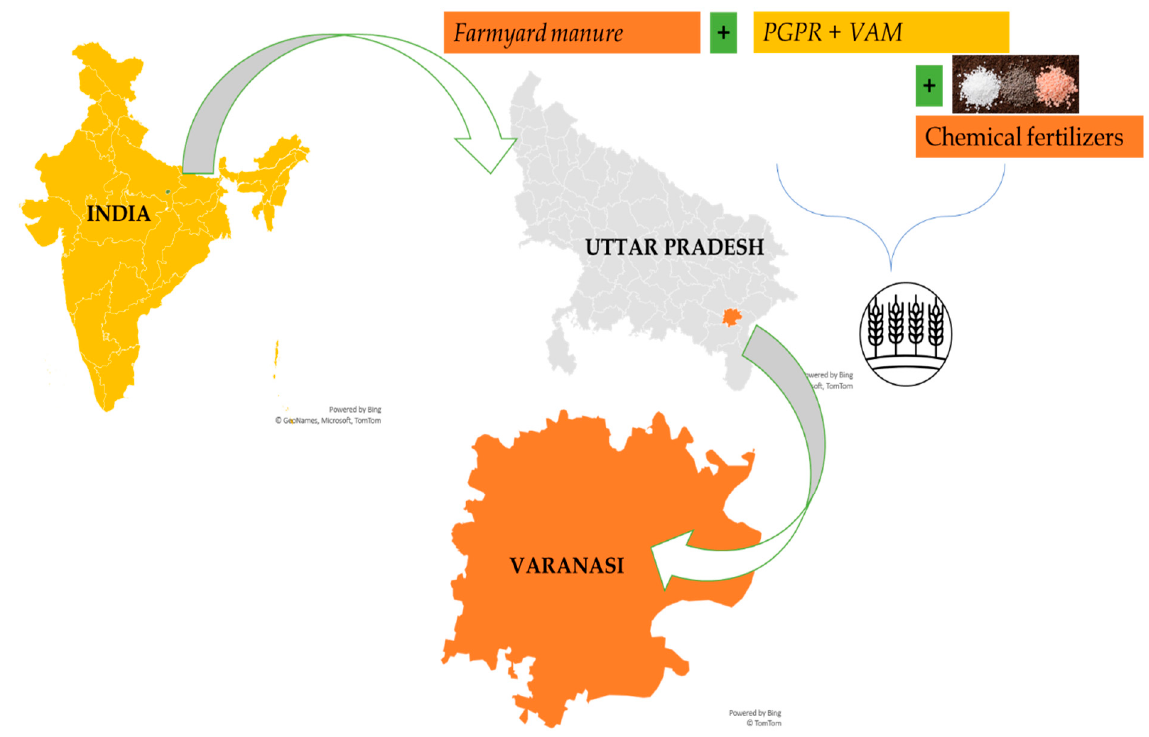
Figure 1. Experimental site for the two-year field experiment.